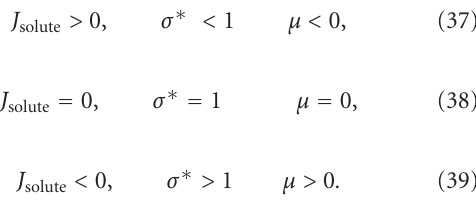
(b) Electrodialysis